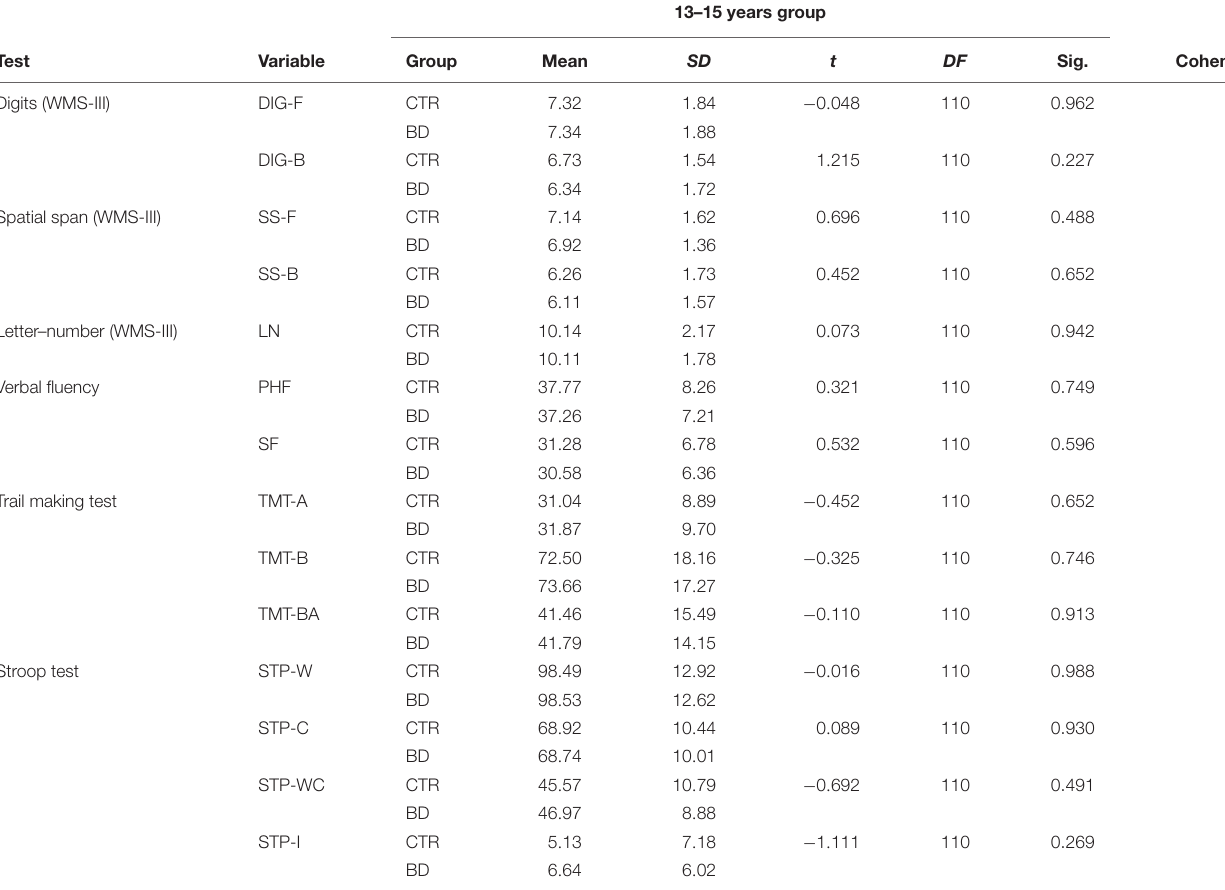
TABLE 3 | Mean differences between BD and control groups of 13–15-year-old